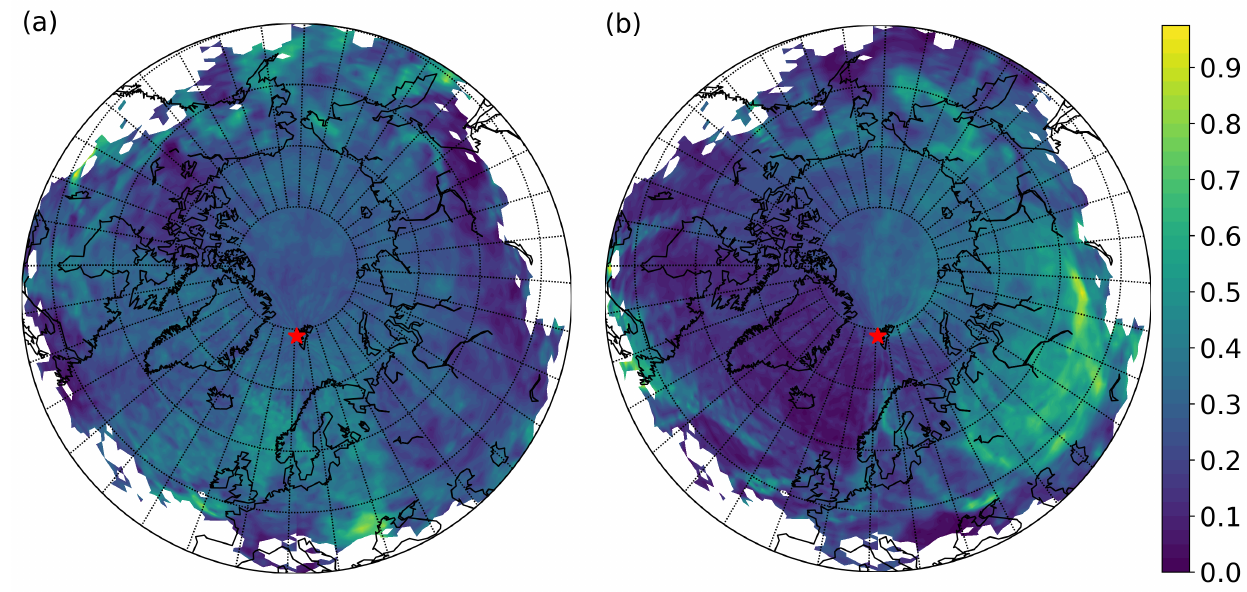
Figure 4. Normalised effective potential source contribution S i , j of absorption for ( a ) Subgroup 1 and ( b ) subgroup 2. The red star marks the location of Zeppelin